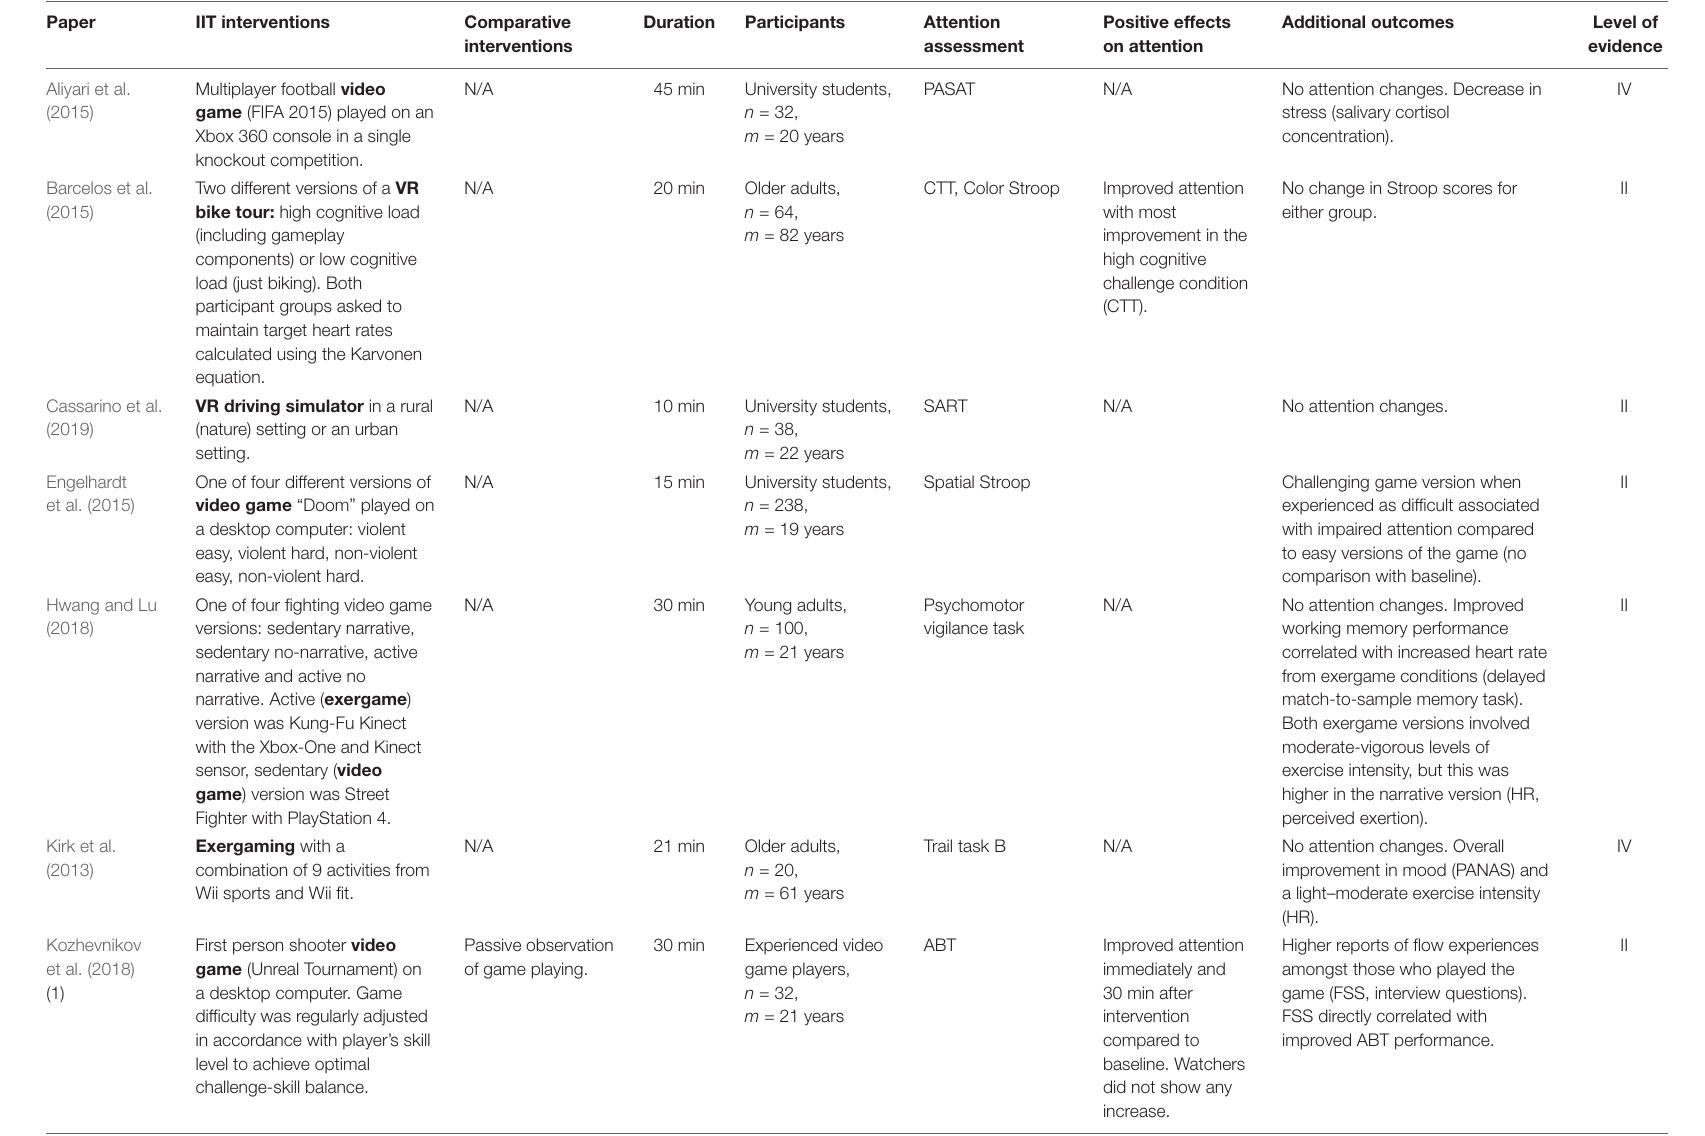
TABLE 1 | Charted data for each of the final reviewed studies. Paper IIT